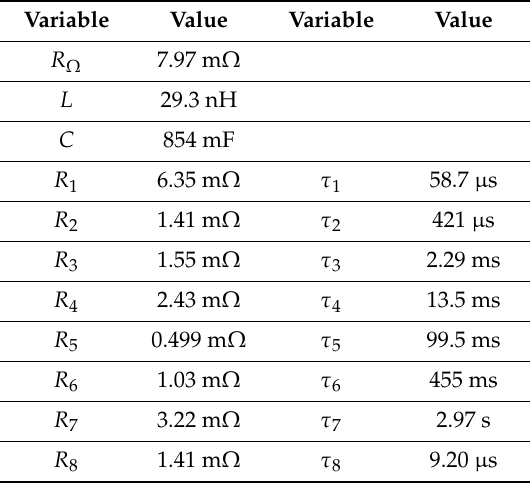
Table 6. Identified polarization contributions of the double-layer capacitor comprising ohmic resistance, inductivity, capacitance, resistive-capacitive, and resistive-inductive elements.